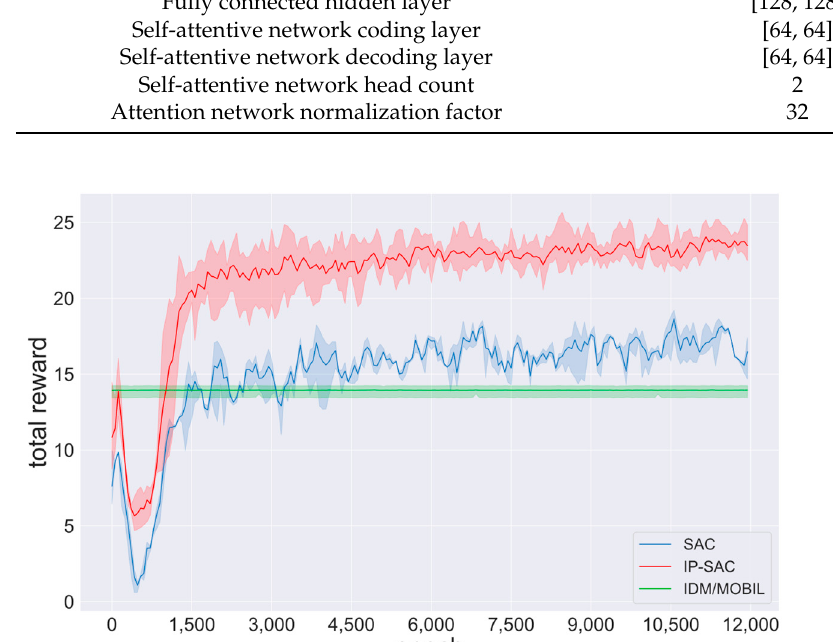
Figure 8. Training convergence curves for different policies.